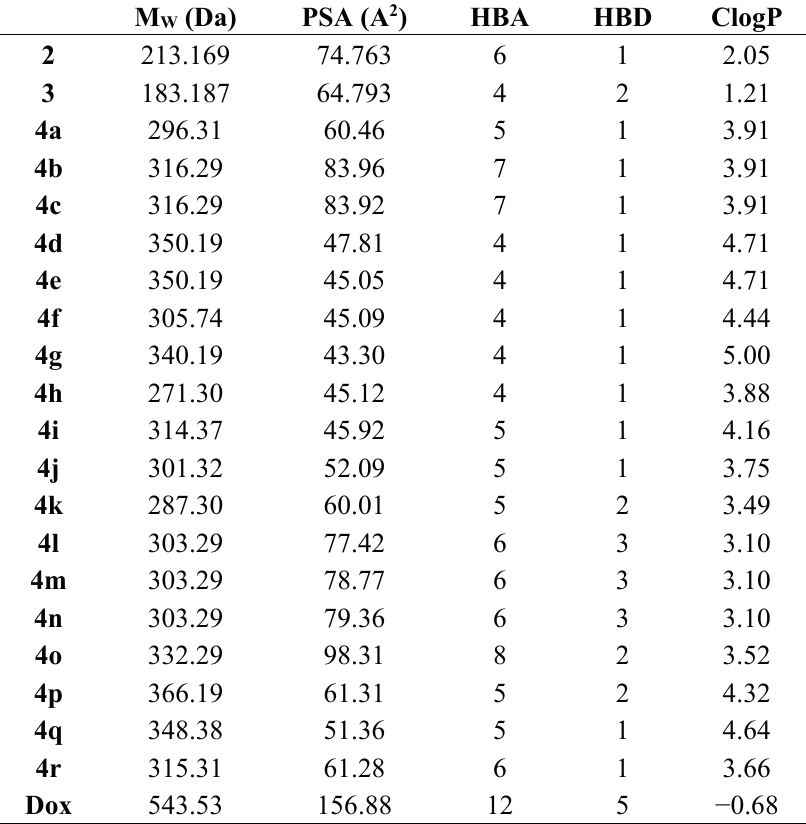
Table 2. Lipinski’s rule of five for compounds 2 , 3 and 4a – r